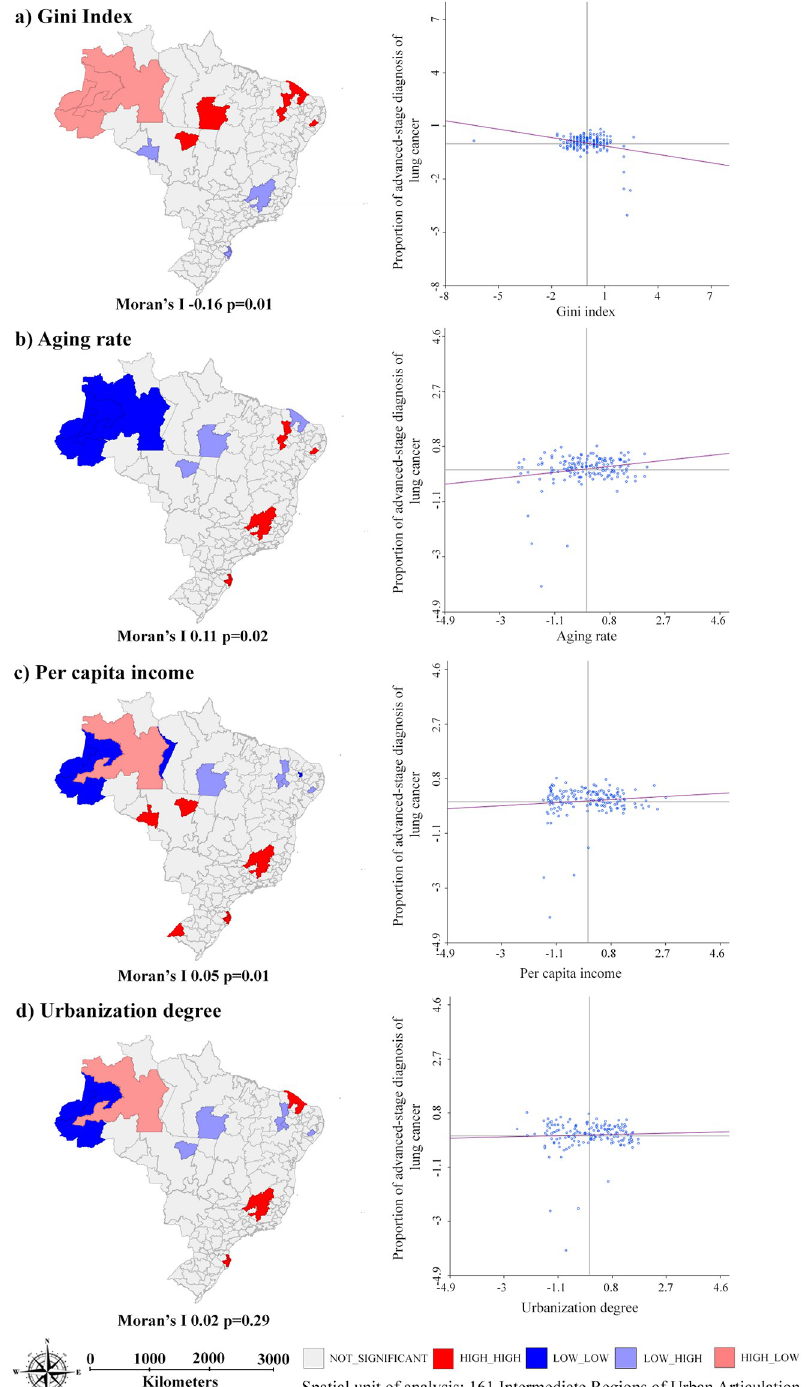
Fig 3. Spatial association between proportion of advanced-stage diagnosis of lung cancer, for both sexes, and demographic and socioeconomic indicators per IRUA Brazil, 2011–2015.